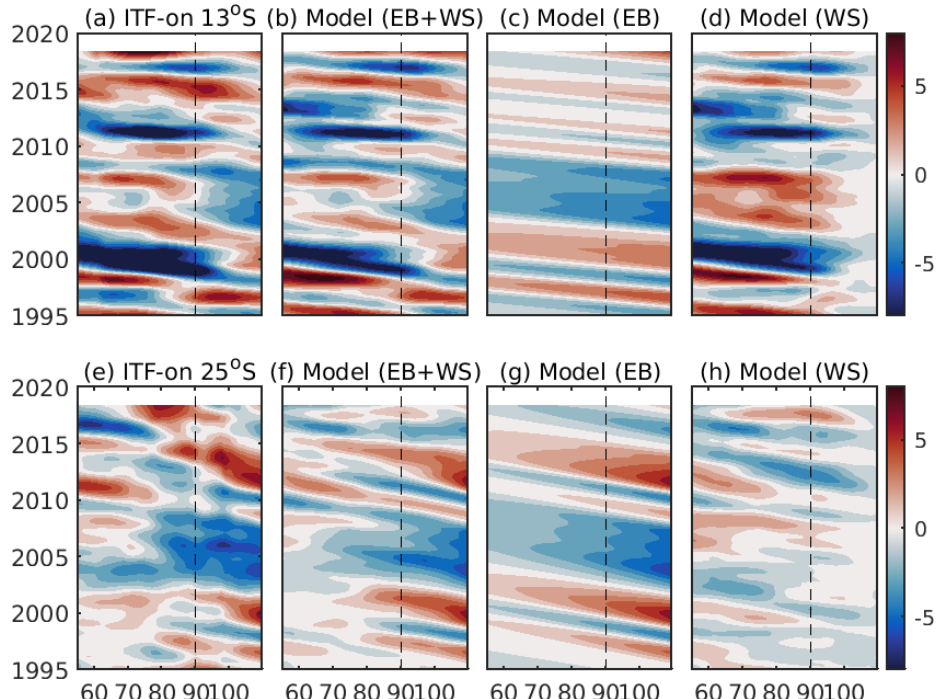
Figure 8. Hovmöller diagrams of (a, e) the ECCO-modeled SLA at 13 and 25 ◦ S from the ITF-on simulation, (b, f) the RG-modeled SLA using both the eastern boundary and the local wind stress curl forcing, (c, g) the RG-modeled SLA obtained using the eastern boundary forcing only, and (d, h) the RG-modeled SLA obtained using the local wind stress curl forcing only. The results from the ITF-on simulation at 13 ◦ S are shown in the top panels, and those at 25 ◦ S are shown in the bottom panels.